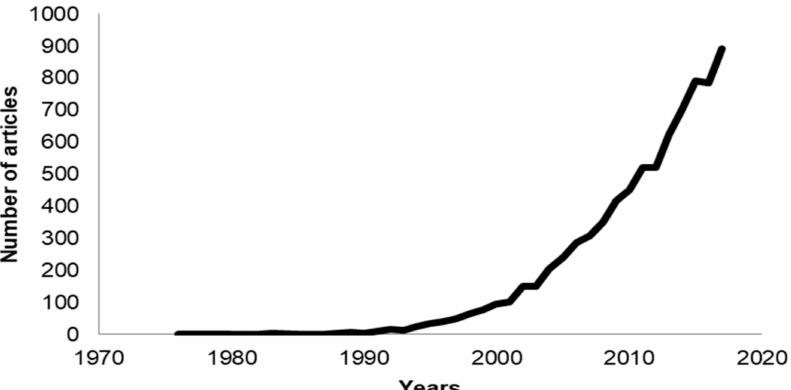
Figure 1. Number of publications in the past 40 years that use the phrases antimicrobial peptide, cell-penetrating peptide, or membrane active